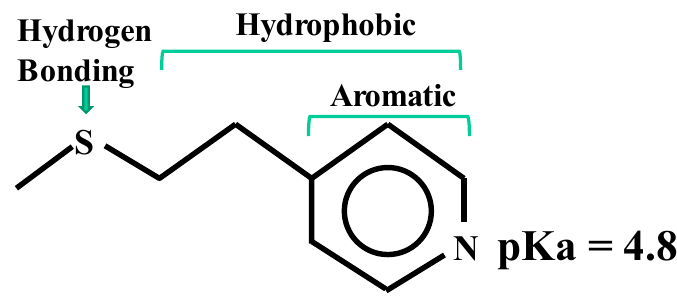
Figure 5. Structure of the MEP (4-Mercapto-ethyl-puridine) ligand.